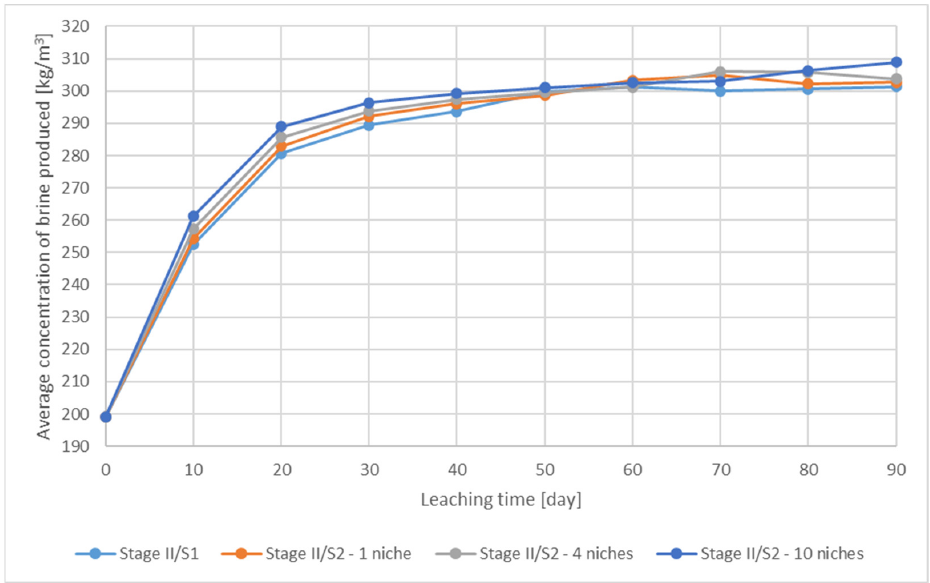
Figure 19. Comparison of the brine changes in the concentration of stage II for different scenarios.